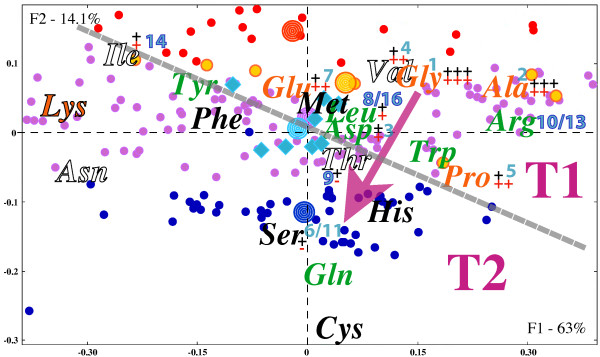
Amino acids distribution and chronological models for the recruitment into the genetic code. Factorial plane representation and species colour coding symbols are as in Figure 1. Dashed diagonal line in grey separates roughly the territory T1 ([high optimal growth temperature]-[high GC content]) from the territory T2 ([moderate optimal growth temperature]-[low GC content]), with arrow pointing from T1 to T2. Colour coding for amino-acids is following the model of Jordan et al. [9]: "strong losers" are orange (Glu, Gly, Ala, Pro); "weak loser" Lys is orange with a black outline; "strong gainers" are filled black (Cys, Ser, His, Phe, Met); "weak gainers" have black outlines (Asn, Ile, Thr, Val); all other amino acids are green. Amino acids found in Miller's experiments [14] or in the Murchison meteorite [15] are labelled with black, respectively red, crosses (the number of crosses, in each colour, follows the reported abundances for the corresponding amino acids; see Additional Table 3 in Jordan et al. [9]). Numbering of amino acids in blue is following the chronology compiled by Trifonov (Figure 1 in [10]; with possible different codon chronologies associated with a given amino acid, such as for Ser ranking 6 or 11 following the codon).